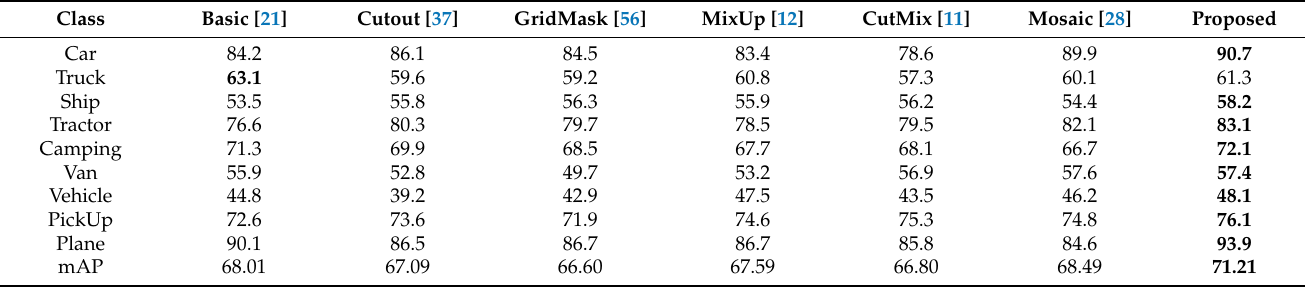
Table 2. Results of VEDAI 512.